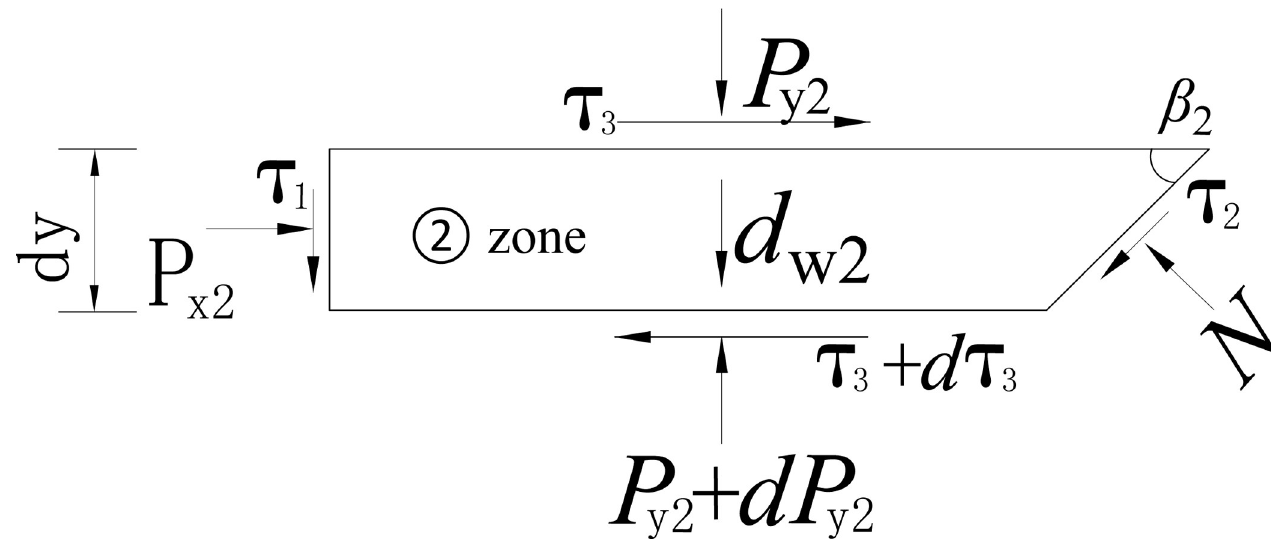
is included in the S2 Appendix. x2